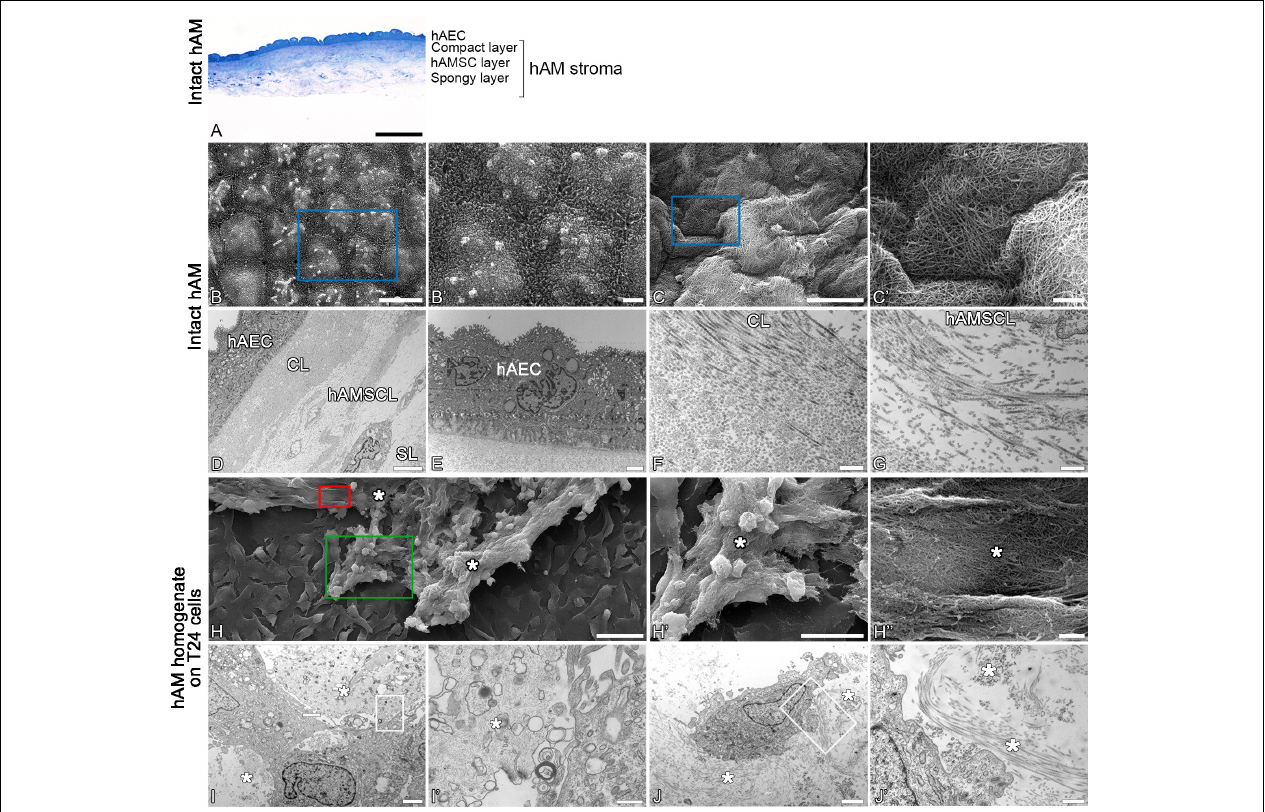
FIGURE 6 | Structure of hAM and hAM homogenate. (A) Intact hAM is comprised of hAEC and hAM stroma, which is further divided into the compact layer, hAMSC layer and spongy layer. (B,B’,D,E) hAEC are of cuboidal form, are well connected and exhibit numerous microvilli at the apical surface. (C,C’,F,G) The fibers that form the extracellular matrix of hAM’s stroma are tightly interwoven. (D) The hAM stroma is further divided into the compact layer (CL), hAMSC layer (hAMSCL), and spongy layer (SL). (H–J) The hAM homogenate applied to T24 cells. The hAM homogenate (white asterisks) consisted of the tightly interwoven fibers of the extracellular matrix of hAM’s stroma and hAM-derived cells. The hAM homogenate applied to T24 cells adhered to the cell surface. The blue rectangles in panels (B,C) mark the areas enlarged in panels (B’,C’) . The green rectangle marks the area enlarged in panel (H’) ; the red rectangle marks the area enlarged in panel (H”) . White framed areas in panels (I,J) mark the areas enlarged in panels (I’,J’) . (A) 100 µ m, (B,C) 10 µ m, (H) 50 µ m, (H’) 25 µ m, (D) 6 µ m, (B’,C,E,H”,I,J) 2 µ m, (J’) 600 nm, (F,G,I’) 400